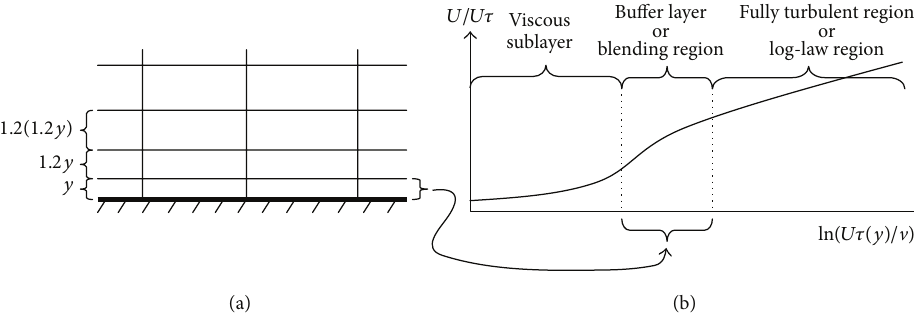
Figure 3: For wall functions, the computational domain starts a distance y from the wall. (a) Grid generation followed from COMSOL 4.2 User’s Guide; (b) the structure of turbulence boundary layer, adapted from Menter [23].